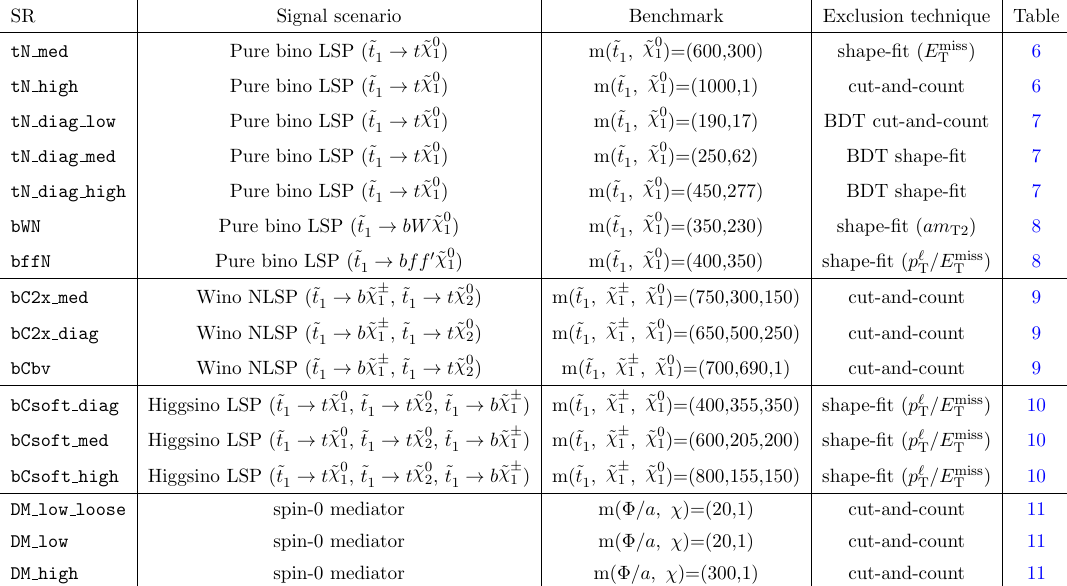
Table 5 . Overview of all signal regions together with the targeted signal scenario, benchmarks used for the optimisation (with particle masses given in units of GeV), the analysis technique used for model-dependent exclusions, and a reference to the table with the event selection details. For the wino NLSP scenario, sbottom pair production (not shown) is also